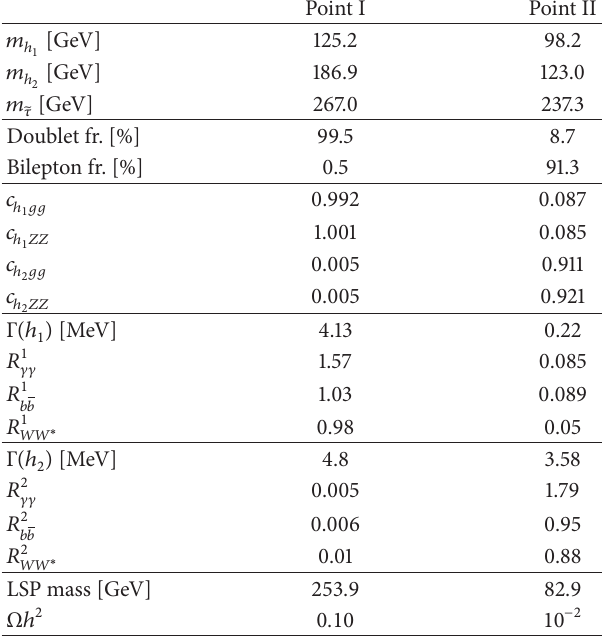
Table 2: The input parameter used: Point I: 𝑚 0 = 673 GeV, 𝑀 1 / 2 = 2220 GeV, 𝐴 0 = − 1842 GeV, tan 𝛽 = 42 . 2, tan 𝛽 󸀠 = 1 . 1556, 𝑀 𝑍 󸀠 = 2550 GeV, and 𝑌 𝑥 = 1 ⋅ 0 . 42 (neutralino LSP); PointII: 𝑚 0 = 742 GeV, = 1572 GeV, 𝐴 = 3277 GeV, tan 𝛽 = 37 . 8, tan 𝛽 󸀠 = 1 . 140, 𝑀 1 / 2 0 = 2365 GeV, and 𝑌 = diag ( 0 . 40 , 0 . 40 , 0 . 13 ) ( CP -odd sneutrino 𝑀 𝑍 󸀠 𝑥 LSP). 𝑐 𝑆𝑉𝑉 denotes the coupling squared of the Higgs fields to vector bosons normalised to the SM